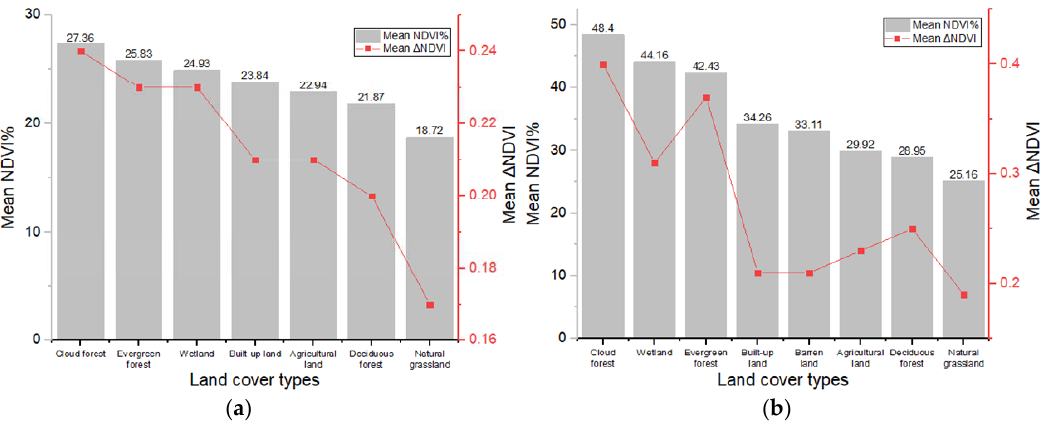
Figure 8. The mean NDVI% and Δ NDVI of different land cover types and their rankings. ( a ) Dominica; ( b ) Puerto Rico. ( b ) Puerto